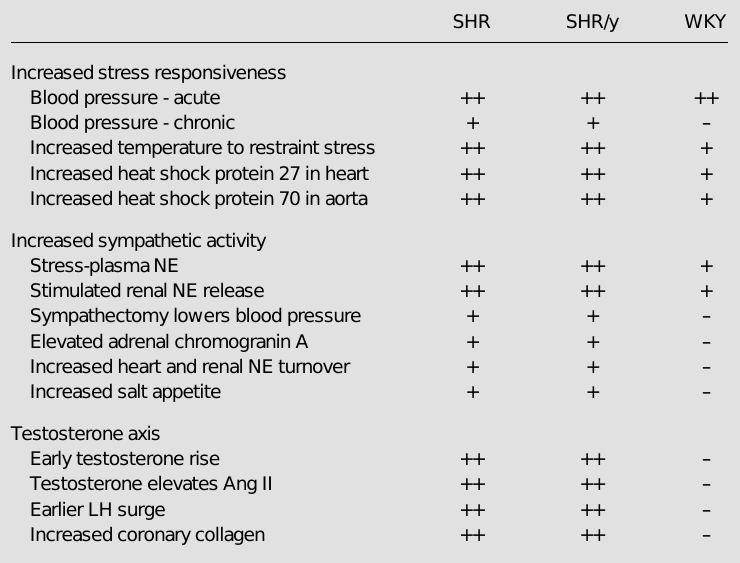
Table 2 - Summary of evidence of Y-SNS-testosterone interaction. The table summarizes the data showing the involvement of the SHR Y chromosome with the SNS, renin-angiotensin and testosterone